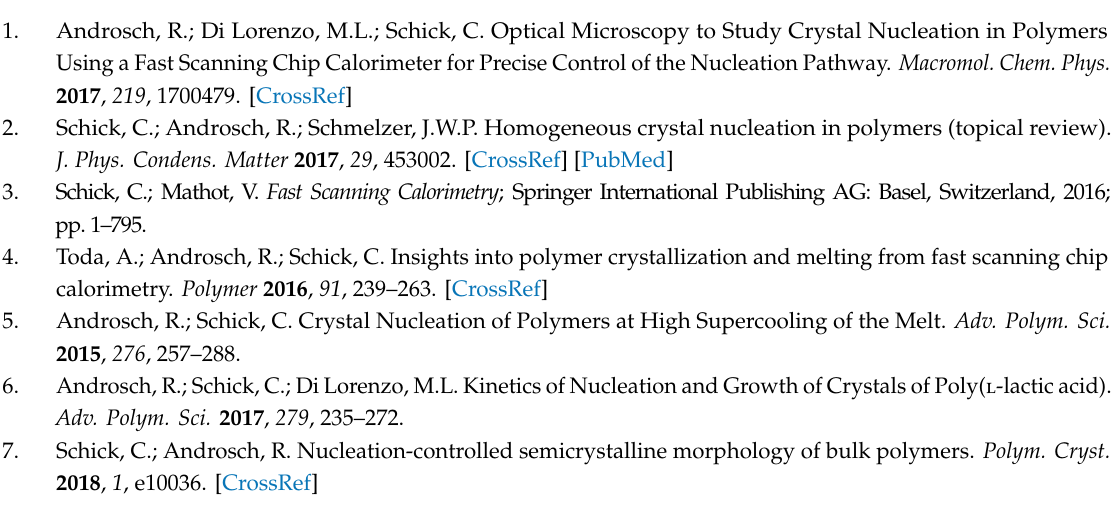
Figure S1. AFM images of PA 66 showing the increase of accessible area. Imaging using sample center (green square) to set the reference amplitude—a and b. Imaging using optimized area (yellow square) to set the reference amplitude—c and d. Figure S2. AFM series of images during crystallization of PA 66 at 480 K. Figure S3. Spherulite growth rate estimation in PA 66, isothermally crystallizing at 480 K. Figure S4. AFM series of images during crystallization of PBN at 460 K. Lines are drawn for visualization of spherulite sizes. Figure S5. Spherulite growth rate estimation in PBN, isothermally crystallizing at 460 K. Figure S6. AFM series of images during crystallization of PBT at 450 K. Lines are drawn for visualization of spherulite sizes. Figure S7. Spherulite growth rate estimation in PBT, isothermally crystallizing at 450 K. Figure S8. Temperature profile of pre-check the sample of PBT by annealing at 290 K for in total 10,000 s. Figure S9. Heating of PBT after quenching at 70,000 K / s (A) and after annealing at 290 K for about 10,000 s (B). The integration was done in OriginLab ™ using a straight line as the baseline. Figure S10. AFM amplitude (left) and phase (right) images of PBT before and after annealing at 290 K for 10,000 s. Intermediate images are omitted, because there are no changes